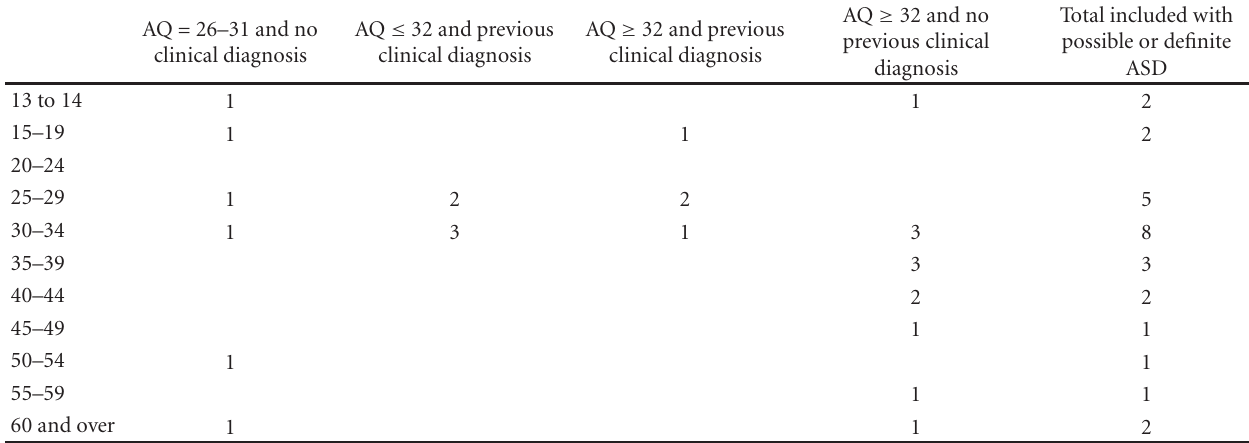
Table 3: Distribution of females with possible or definite diagnosis of HFPDD by age.